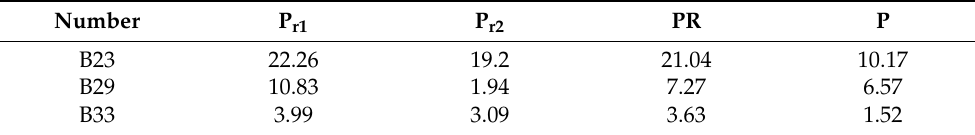
Table 4. Comparison table of the predicted and proved resources ( × 10 4